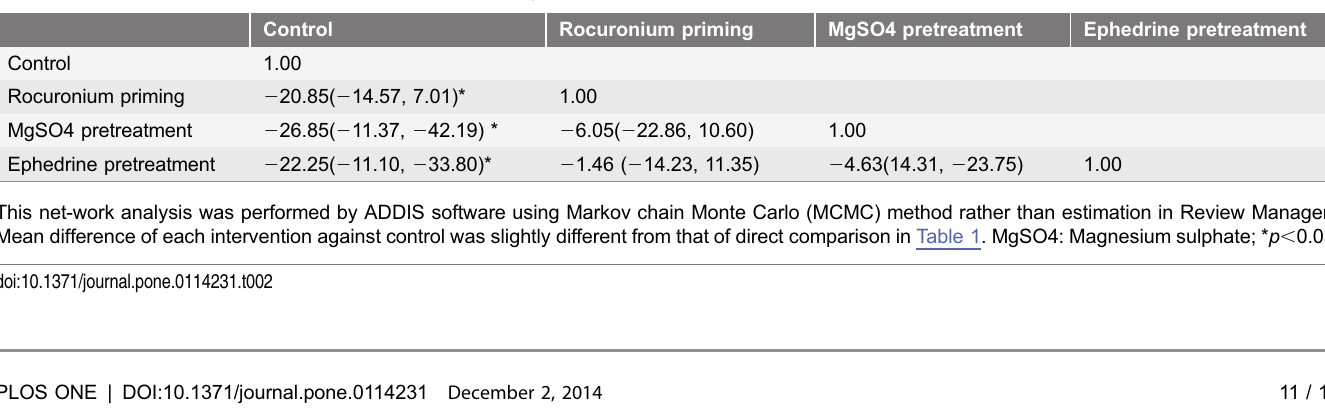
Table 2. Indirect comparisons between effective pharmacologic